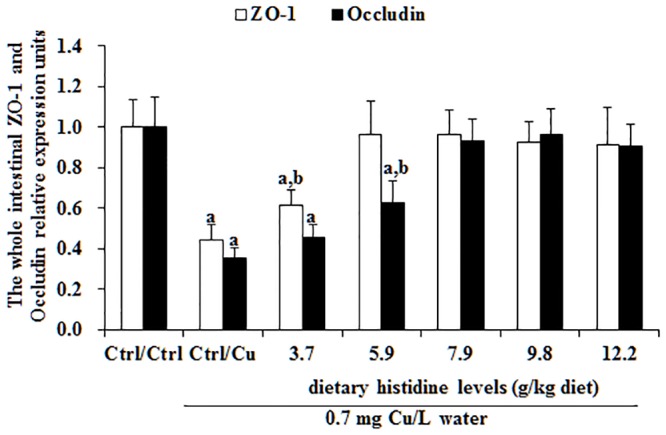
The ZO-1 and occludin mRNA levels in entire intestines of grass carp fed with different histidine doses.The protocol and indications are shown in Fig 3.